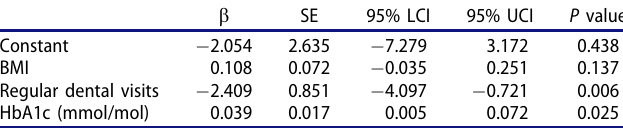
Table 3. Multiple linear regression analysis of exposure variables on the abso- lute number of decayed